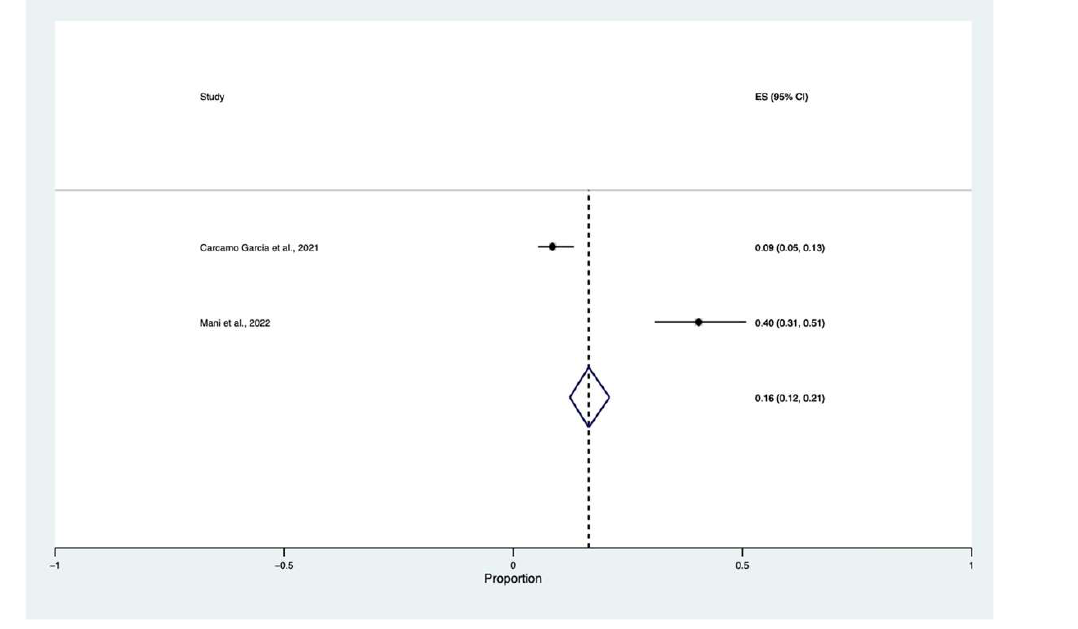
Figure 3. Proportional meta-analysis of cumulative “visual loss” incidence in COVID-19 patients